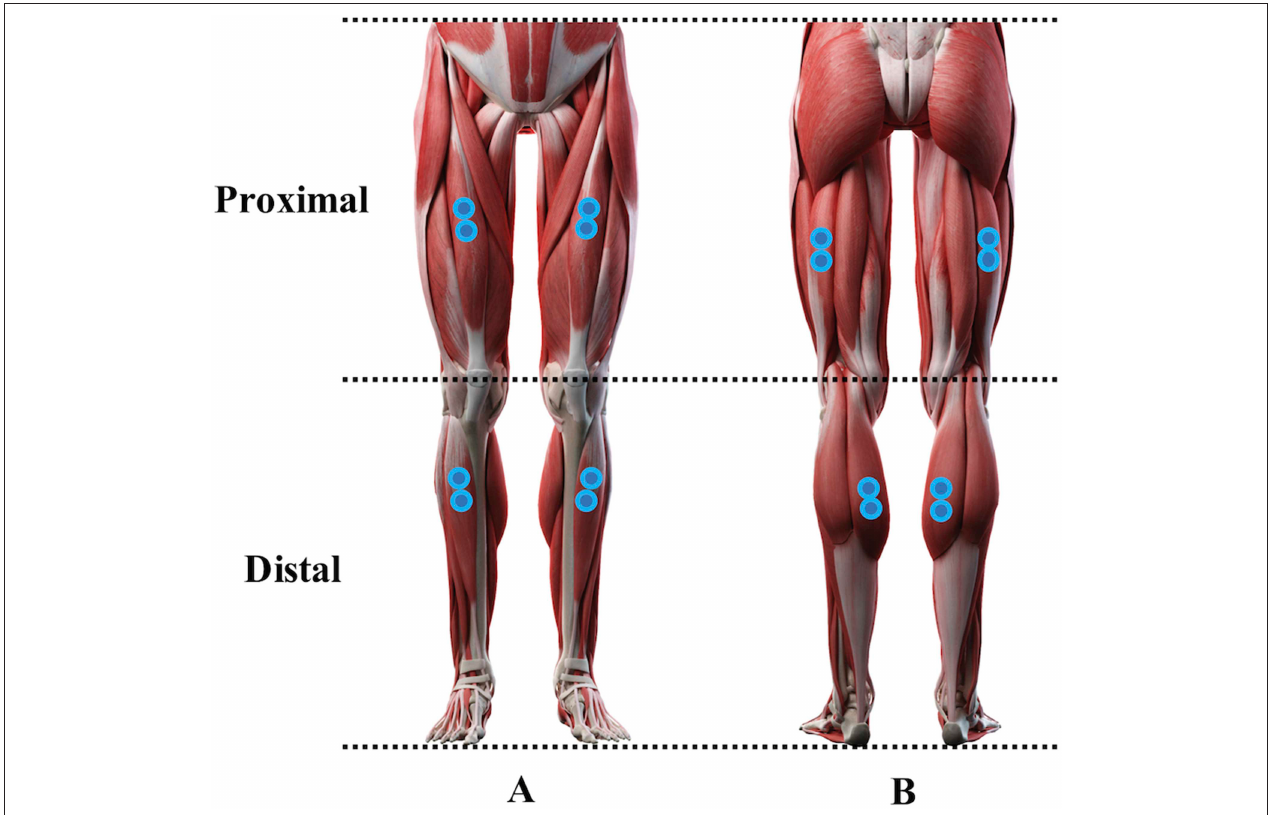
FIGURE 1 | Anterior (A) and posterior (B) representation of the electrodes position over the muscles analyzed in the study. A pair of electrodes were placed over proximal muscles [bilateral rectus femoris (A) and biceps femoris (B) ] as well as over distal muscles [bilateral tibialis anterior (A) and gastrocnemius medialis (B) ] (Sebastian